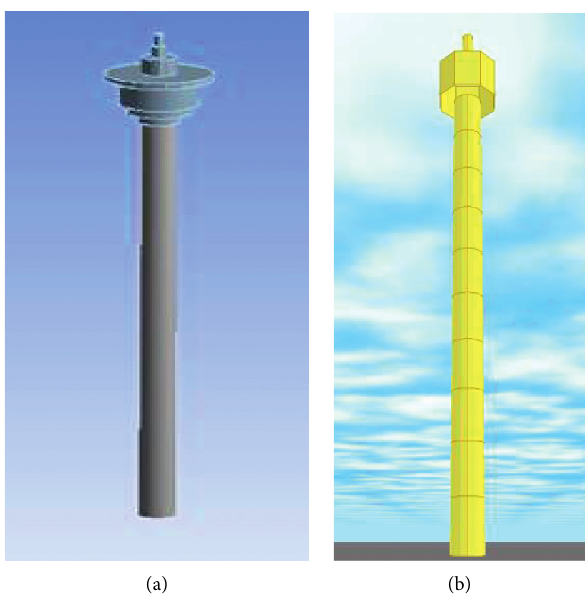
Figure 5: Structural analysis model. (a) ANSYS. (b)